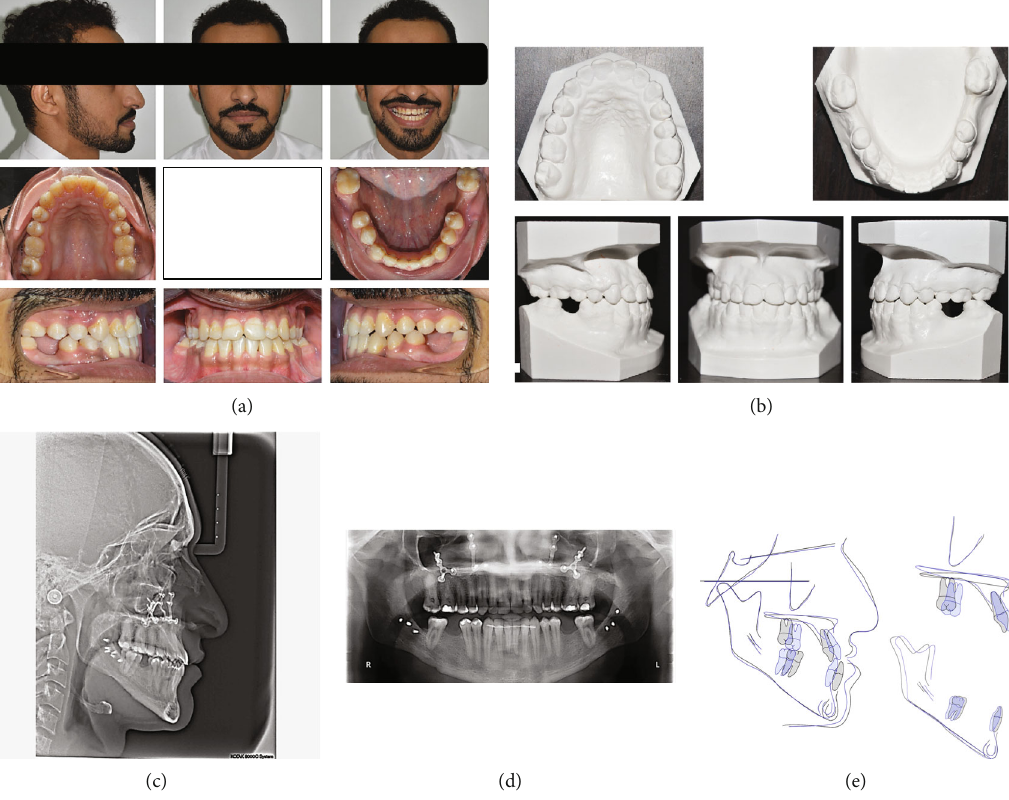
Figure 3: Posttreatment extraoral and intraoral photographs, study models cephalometric radiograph, and panoramic radiographs of the patient: (a) extraoral and intraoral photographs; (b) study models; (c) cephalometric radiograph; (d) panoramic radiograph; (e) cephalometric